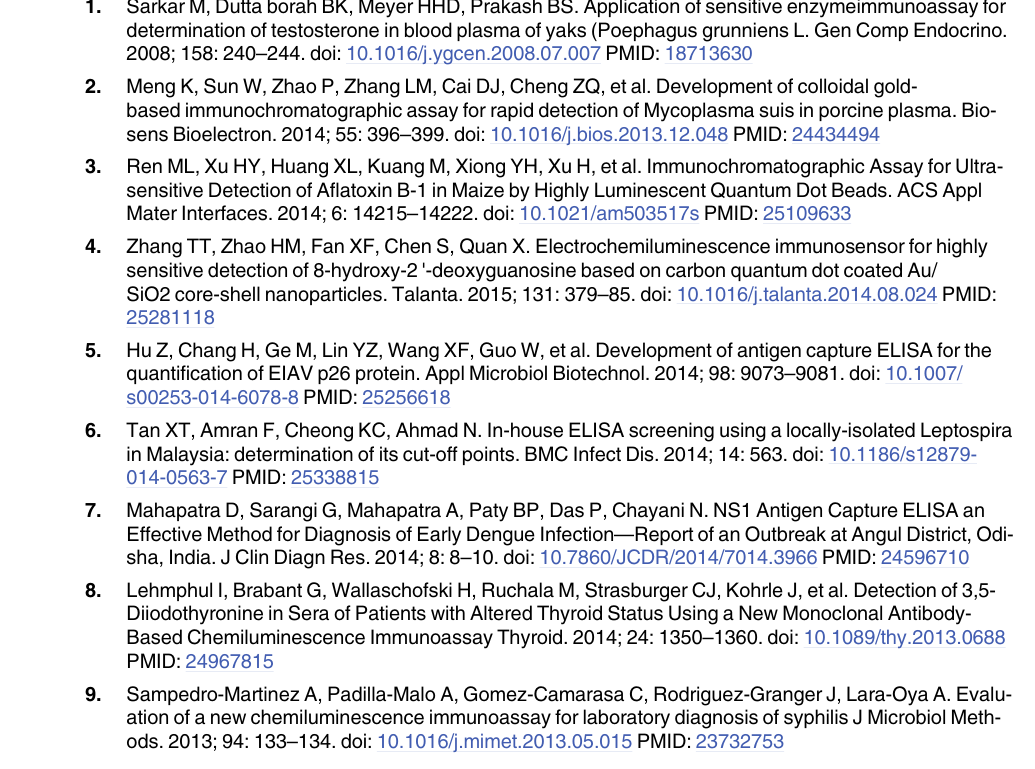
S3 Table. Optimization of FT4 assay: the concentration of dilution MMPs and ratios of Eu 3+ -labeled T4. The optimal conditions were obtained by orthogonal analyses on the data of the experiment. Similarly, as shown in S3 Table, when the concentration of MMPs and dilution ratios of antibody reached 300 μ g/mL and 1/25, respectively, the fluorescence intensity was no longer increasing significantly. Thus, 300 μ g/mL of MMPs and a dilution ratio of 1/25 was selected as the optimal condition for FT4